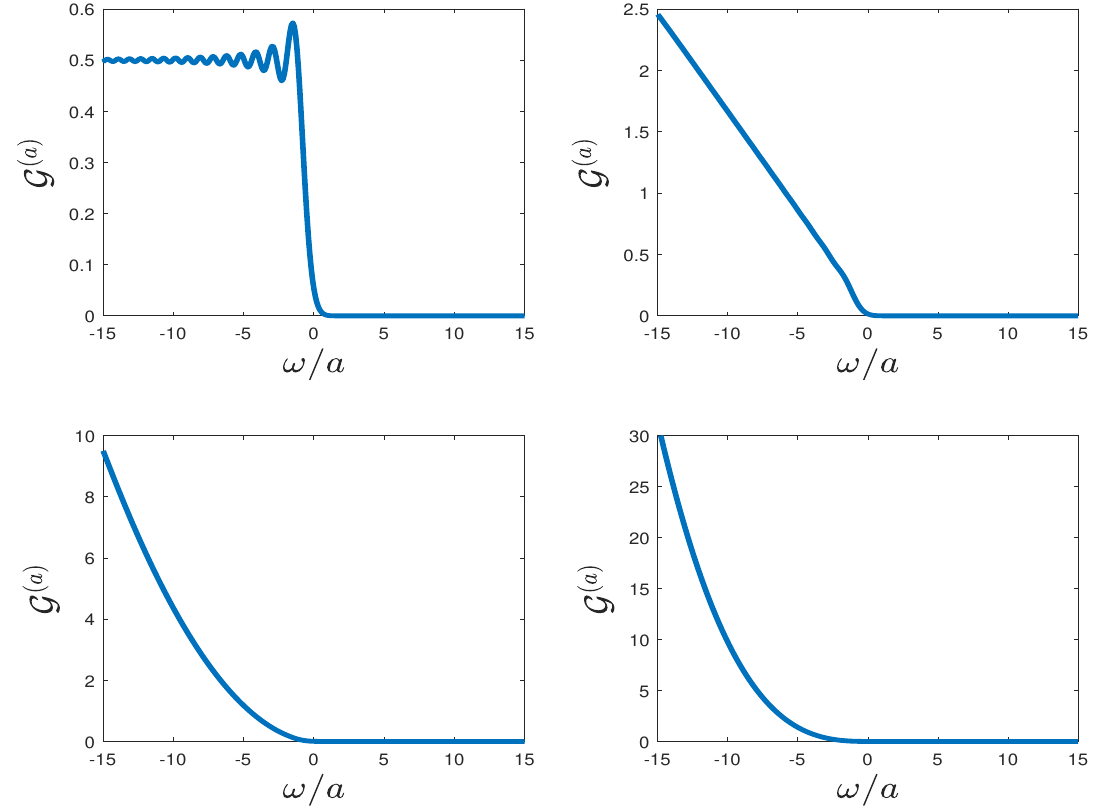
Figure 11 . Behavior of G ( a ) for massive field in different spacetime dimensions. The four subfigures stand for D = 3 , D = 4 , D = 5 , and D = 6 , respectively, from left to right and top to